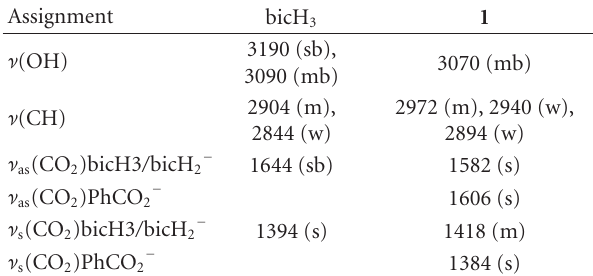
Table 5: Most characteristic and diagnostic IR fundamentals (cm − 1 ) for bicH 3 and complex 1